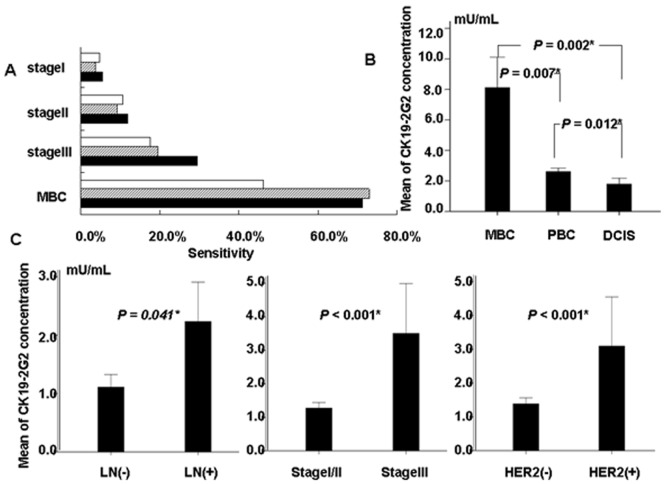
The sensitivity of CEA, CA153 and CK19-2G2 for PBC and MBC.(A) CK19-2G2 is superior to CEA and CA153 in stage II and III breast cancer patients and as sensitive as CA153 in MBC patients. The blank bar: CEA; the gray bar: CA153; the black bar: CK19-2G2 (B) The distribution of CK19-2G2 in MBC, PBC and DCIS. Serum CK19-2G2 levels in MBC are higher than those in the PBC and DCIS respectively(MBC vs PBC, P = 0.007; MBC vs DCIS, P = 0.002). Serum CK19-2G2 levels in PBC are higher than those in DCIS (P = 0.012). Error bars are referring to SE(Standard Error). (C) The distribution of CK19-2G2 in breast cancer patients with different stages, lymph nodes status and HER2 status. Patients with positive lymph nodes, stage III and HER2 positive status had higher serum CK19-2G2 levels than those with negative lymph nodes, stage I/II and HER2 negative status. Error bars are referring to SE(Standard Error).